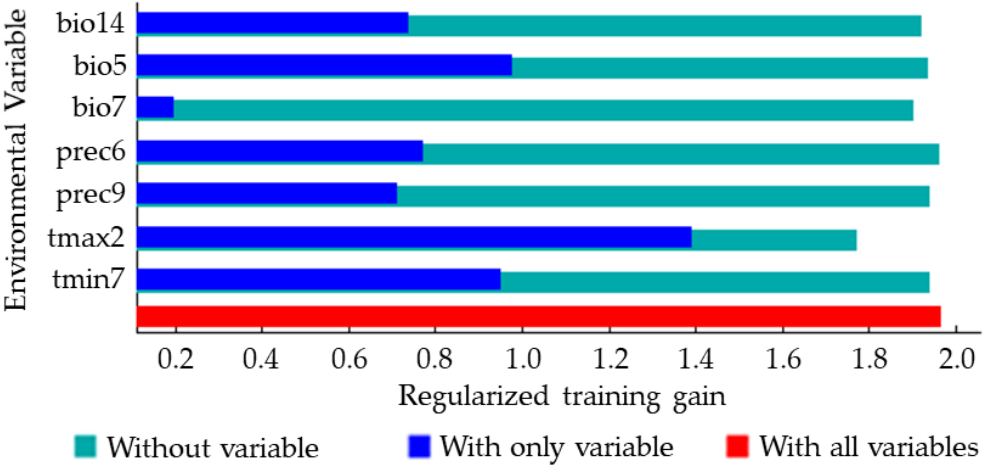
Figure 5. Jackknife analysis result showing the most influential environmental variables predicting potentially suitable distribution areas of S. juvencus around the world. The monthly average maximum temperature in February (tmax2) significantly contributed to explaining the suitability of the area for S. juvencus . And tmax2 has the most information that is not present in the other environmental variables.